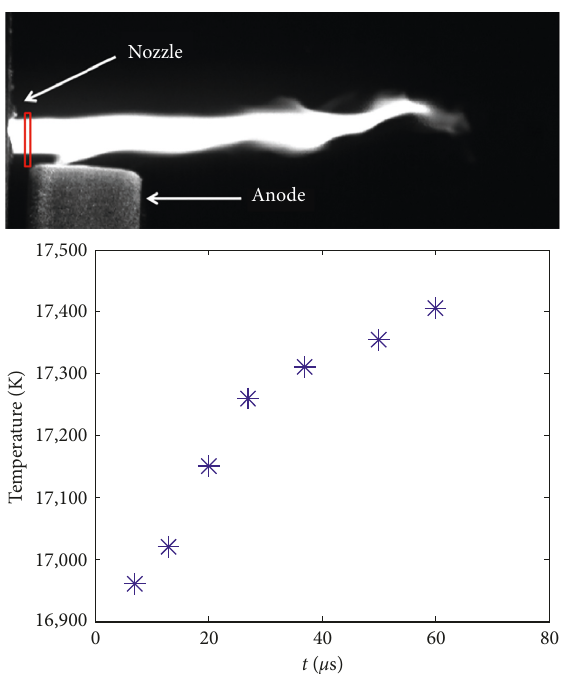
Figure 6: Temporal evolution of temperature during one period of restrike mode (measured in position 1 as shown by the red rect- angle in high-speed camera image above the